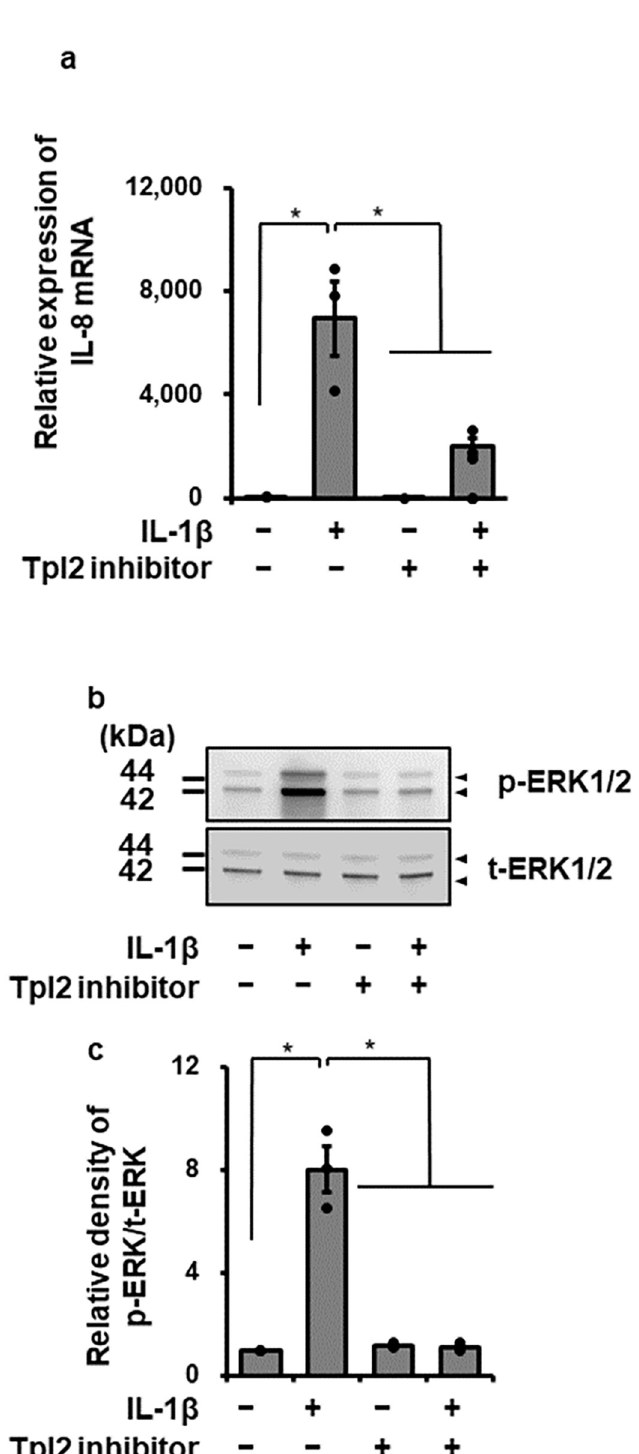
Fig 5. Inhibitory effect of a Tpl2 inhibitor on IL-1 β -induced IL-8 mRNA expression and ERK1/2 phosphorylation in canine dermal fibroblasts. Canine dermal fibroblasts were pretreated with or without Tpl2 kinase inhibitor II (10 μ M) for 1 h and subsequently stimulated with or without IL-1 β (100 pM). (a) After stimulation for 6 h, IL-8 mRNA expression levels were determined. TBP was used as an internal standard and the expression levels of IL-8 mRNA in IL-1 β -stimulated cells were compared with the expression at 0 h. (b, c) After stimulation for 15min, phosphorylated ERK1/2 (p-ERK1/2) and total ERK1/2 (t-ERK1/2) were detected by western blotting. Representative western blotting